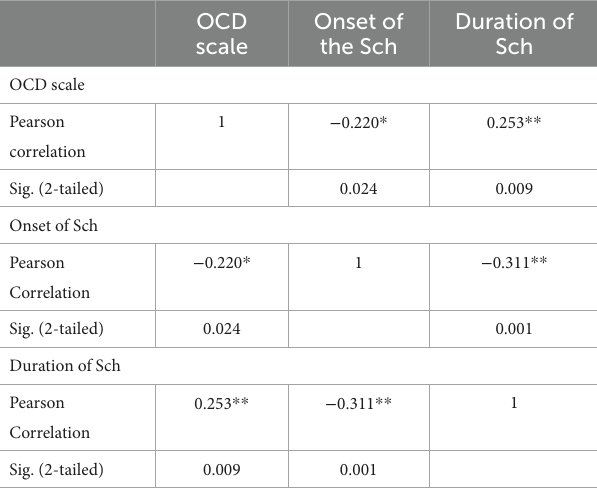
TABLE 5 Effect of symptoms on scores of OCS in patients with